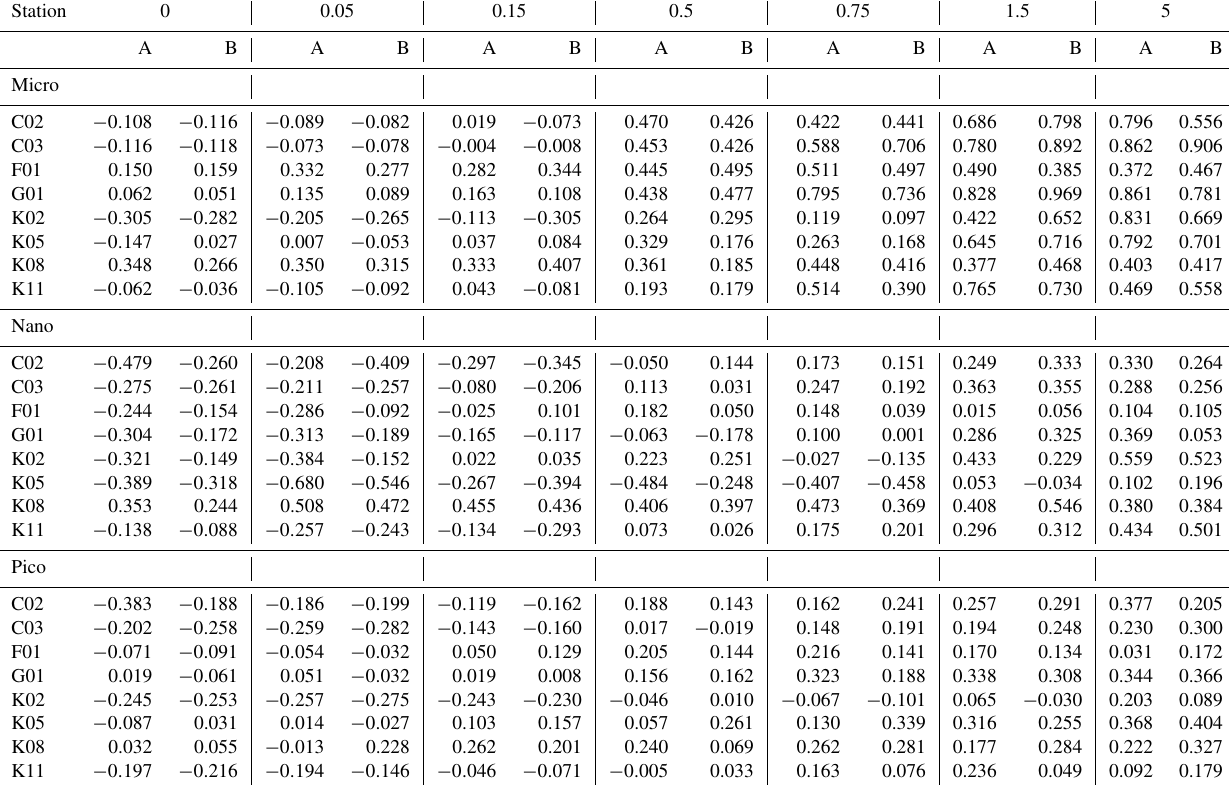
Table 2. Phytoplankton growth rate (d − 1 ) derived from the gradient-enrichment experiments (EXP a ) in the ECS-Kuroshio. Enriched nitrate concentrations (µmolL − 1 ) are shown at the top of each column. A and B: duplicate bottles. Pico: chlorophyll smaller than 2µm. Nano: chlorophyll between 2 and 11µm. Micro: chlorophyll larger than